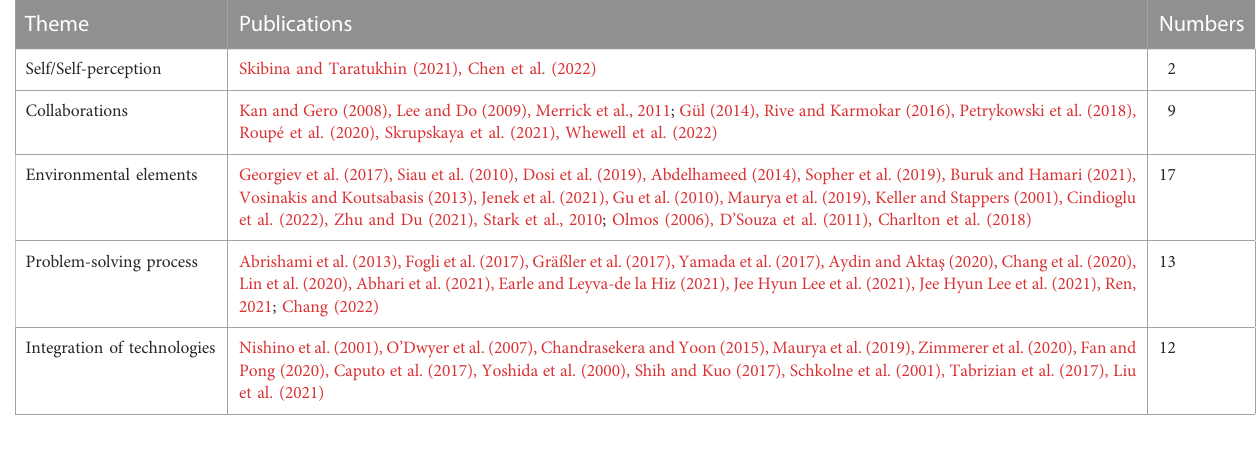
TABLE 2 Themes and publications under each theme.